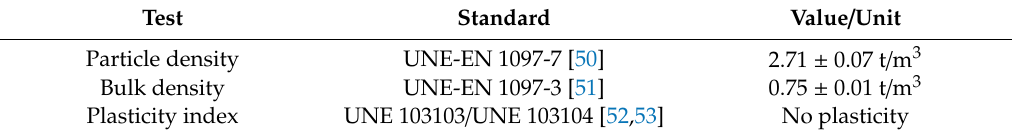
Table 6. Density and plasticity tests for the fine portion of ladle furnace slag.